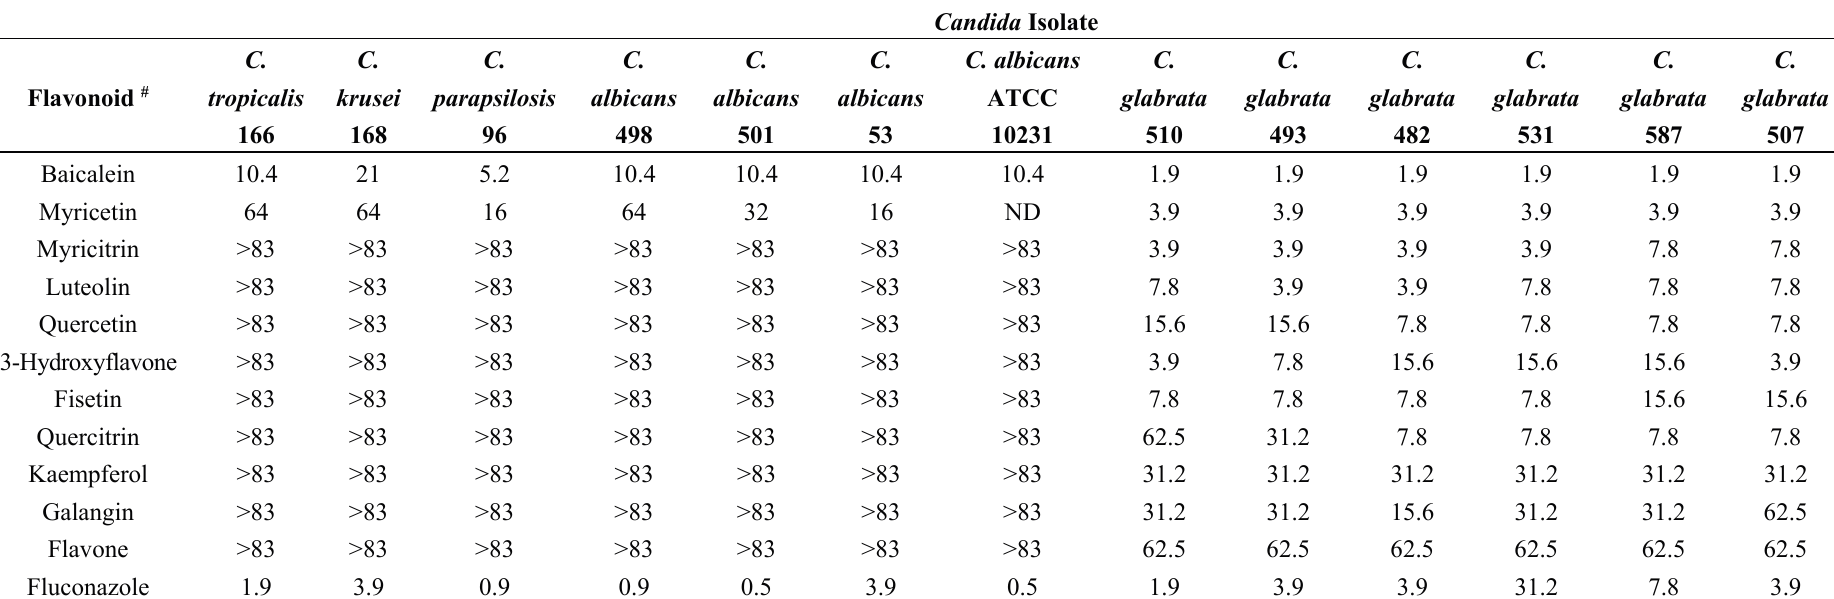
Table 1. MIC values of flavonoids on isolates of Candida